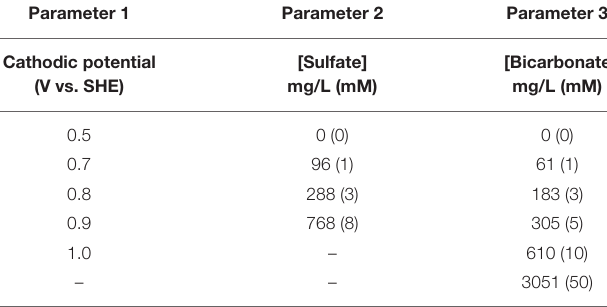
TABLE 1 | Experimental